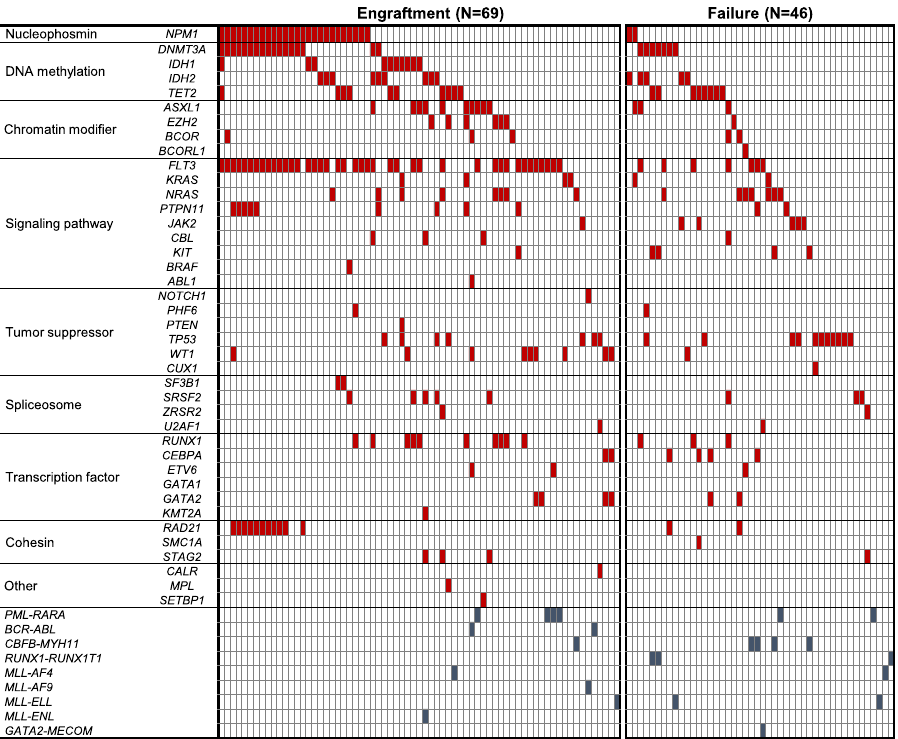
Fig. 1 Mutational landscape of 115 primary AML patients according to the engraftment status in NOG mice. Each column represents each patient. Signaling, epigenetic, and cohesin genes are separated into functional